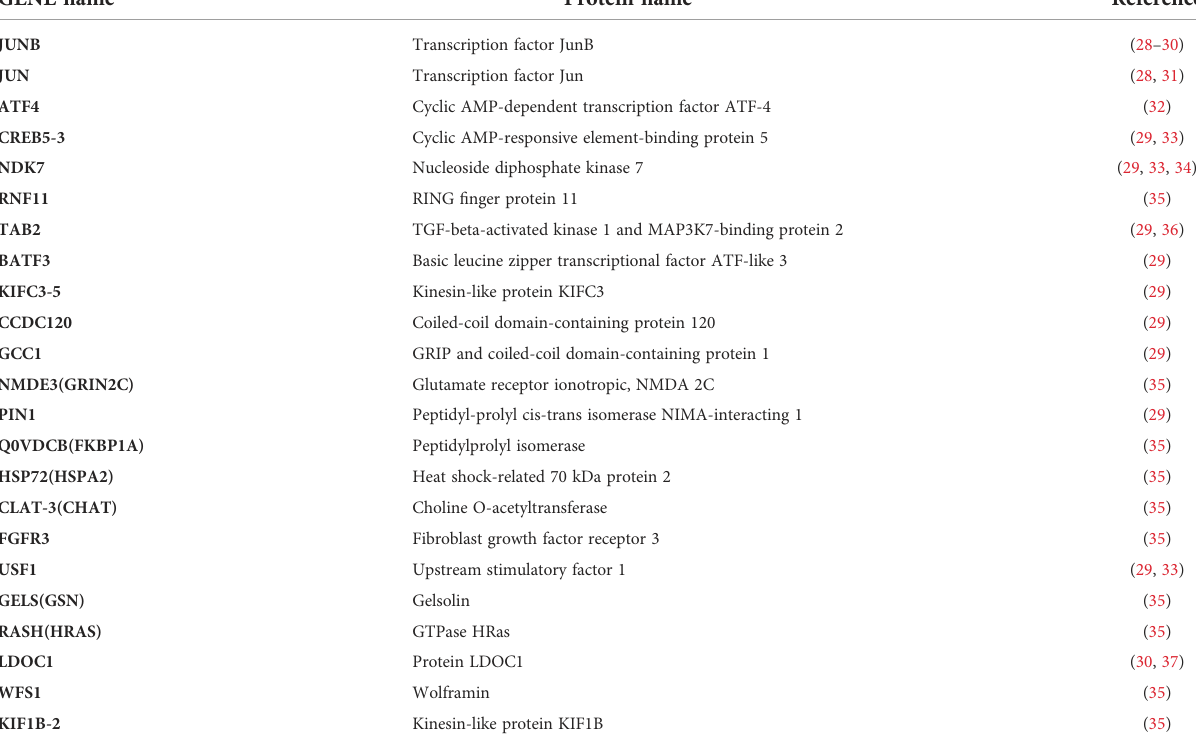
TABLE 1 | Interaction protein of Fra-1